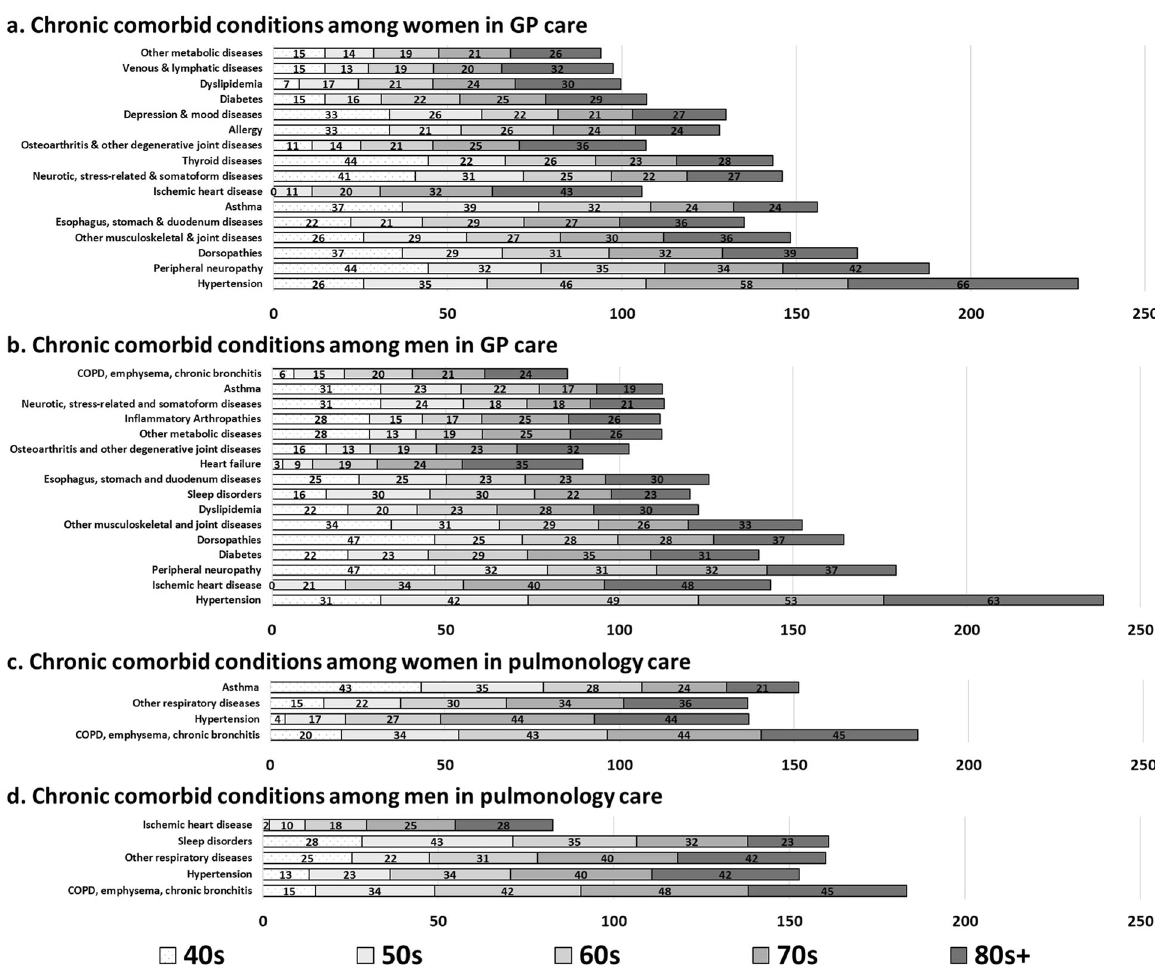
Fig. 4 Chronic comorbid conditions (CCC) with >20% frequency by gender and age group for GP and pulmonology practices. Each segment of bars represents the frequency (%) of the listed comorbid condition for each age group. The conditions are presented in the reverse order of overall frequency by gender and